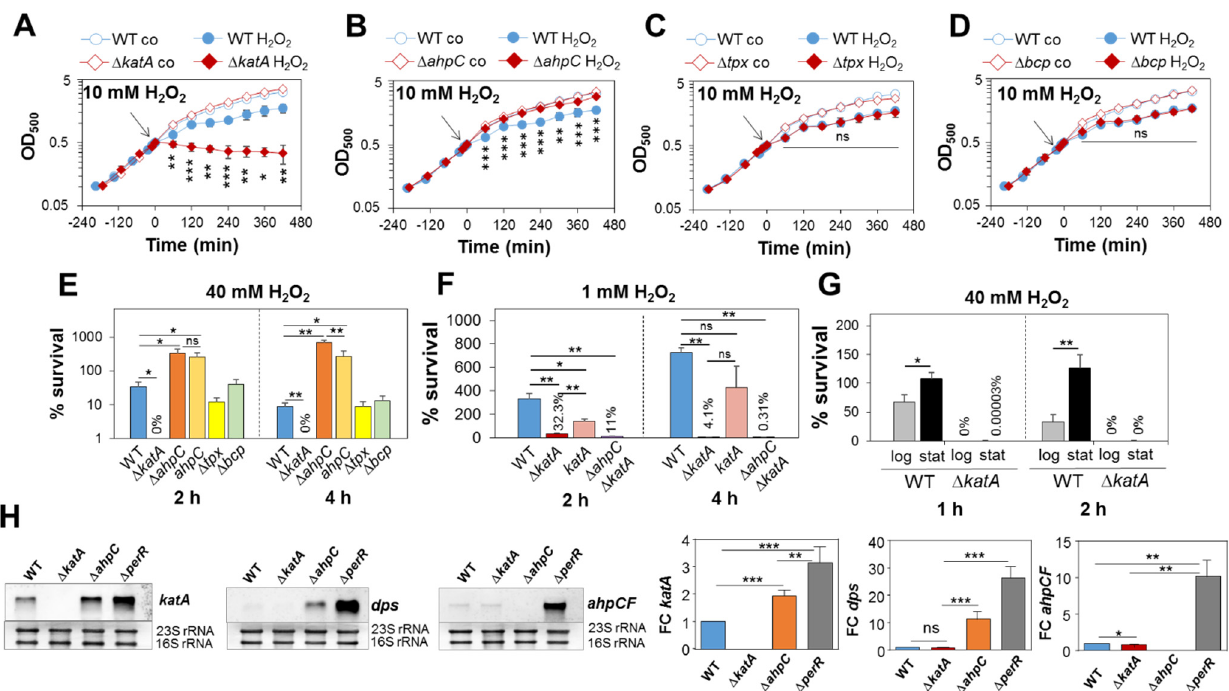
Figure 1. KatA confers strong H 2 O 2 resistance during aerobic growth, while Tpx and Bcp are not required for H 2 O 2 resistance. ( A – D ) Growth curves of S. aureus COL WT, Δ katA ( A ), Δ ahpC ( B ), Δ tpx ( C ) and Δ bcp mutants ( D ) in RPMI medium before (co) and after exposure to 10 mM H 2 O 2 at an OD 500 of 0.5. ( E ) Survival rates were determined as CFU counts for S. aureus COL WT, Δ katA , Δ ahpC , Δ tpx and Δ bcp mutants and the ahpC complemented strain at 2 and 4 h after treatment with 40 mM H 2 O 2 . ( F ) Survival rates were analysed for the WT, Δ katA and Δ ahpC Δ katA mutants and the katA complemented strain ( katA ) after 2 and 4 h of exposure to 1 mM H 2 O 2 based on CFU counts. ( G ) S. aureus COL WT and Δ katA mutant cells were exposed to 40 mM H 2 O 2 during the log and stationary phases at OD 500 of 0.5 and 2–3, respectively. In (E–G), the survival rates were calculated relative to the untreated control, which was set to 100%. Mean values and standard deviation (SD) from three to four biological replicates are shown. ( H ) Northern blot analyses of the katA , dps and ahpCF specific transcripts in the S. aureus WT, Δ katA , Δ ahpC and Δ perR mutants. The methylene blue stains below the Northern blot images denote the bands of the 16S and 23S rRNAs used as RNA loading controls. Quantification of the intensities of the Northern blot bands was performed from two biological and three technical replicates using Image J and is shown in the diagrams as fold changes (FCs) of induction of the katA , dps and ahpCF transcripts in the mutants relative to the WT. Error bars represent the SD. The statistics were analysed using Student’s unpaired two-tailed t-test in Graph Prism. Symbols: ns p > 0.05, * p ≤ 0.05, ** p ≤ 0.01 and *** p ≤ 0.001.